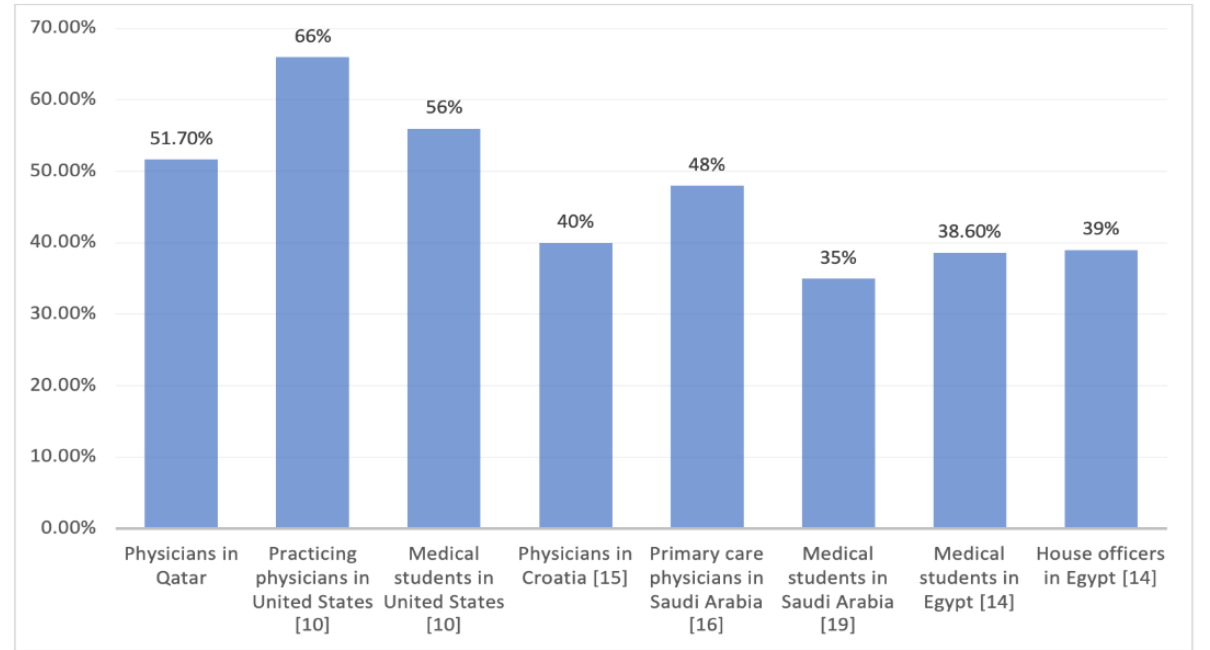
Figure 2. Comparison of the mean Assessment of Sleep Knowledge in Medical Education (ASKME) Survey scores obtained by physicians participating in this study and those obtained by physicians and students in studies in other countries using the same assessment tool